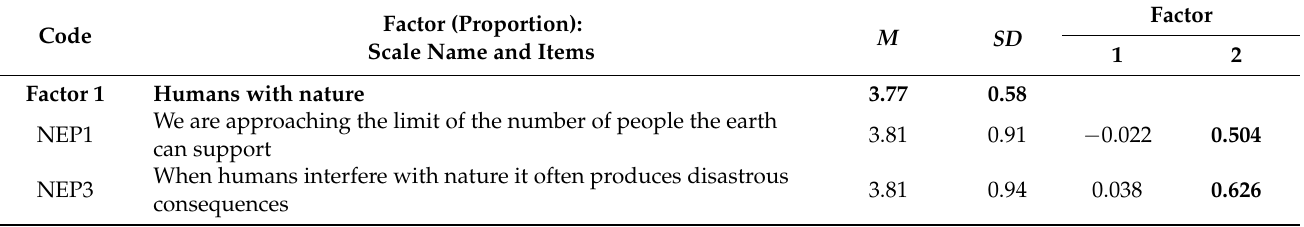
Table A2. Summary results of exploratory factor analysis for New Ecological Paradigm ( n = 605, 2019